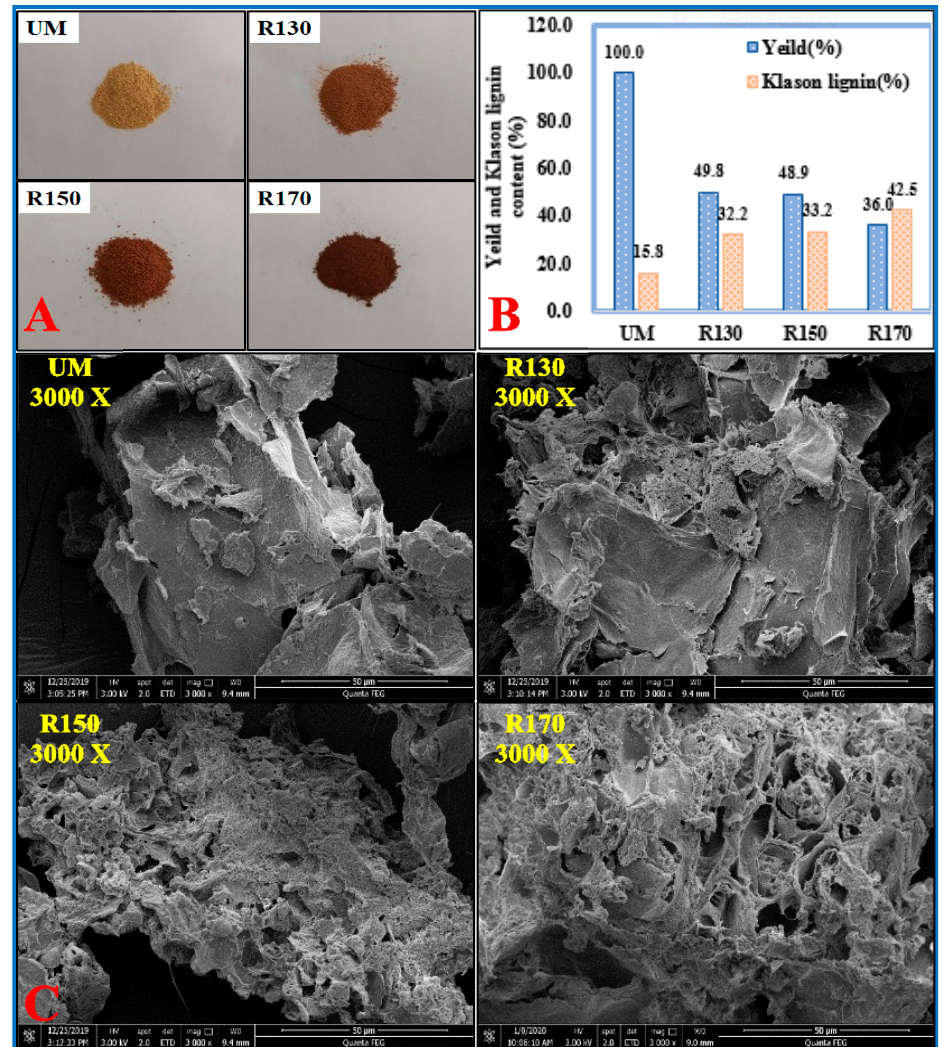
Figure 1. ( A ) Morphological changes in Chinese quince fruits residues before and after subcritical water treatment. ( B ) Yield (% dry initial material) and Klason lignin content of the Chinese quince fruit residues before and after subcritical water pretreatment. ( C ) SEM images of samples obtained from Chinese quince fruit residues before and after subcritical water treatment. UM, R130, R150, and R170 represent the untreated and pretreated Chinese quince by subcritical water at 130, 150, and 170 °C, respectively.